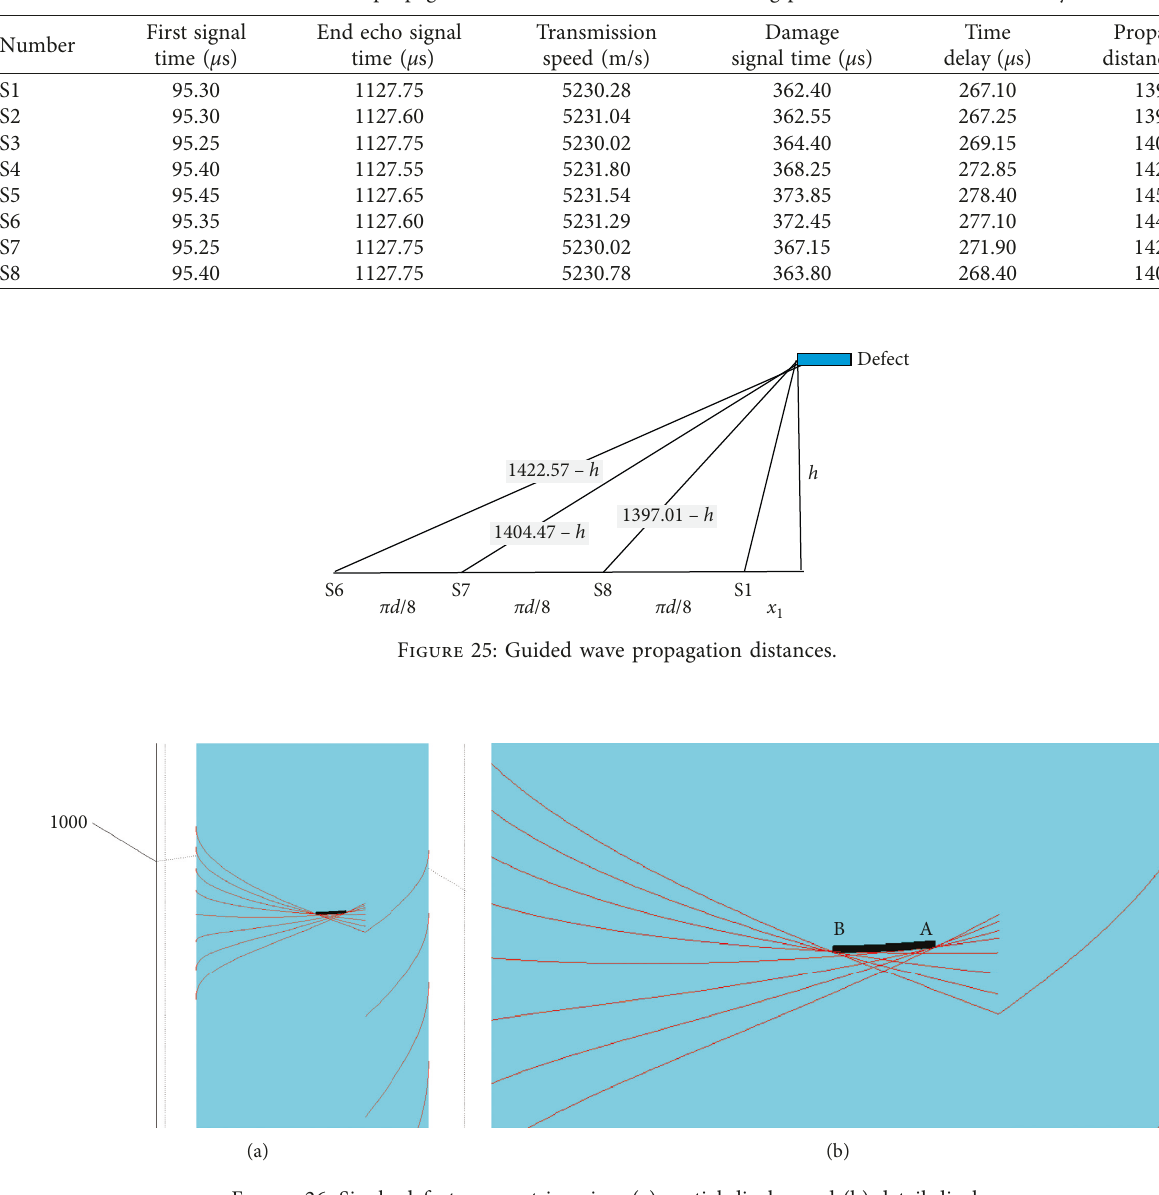
Table 4: Guided wave propagation distances between the receiving point and the defect boundary.